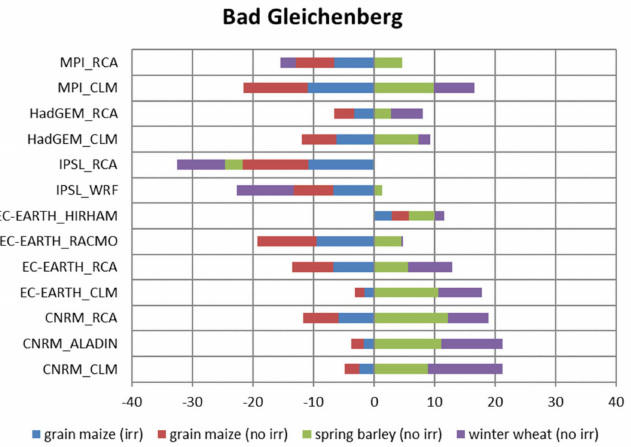
Figure 9. Yield differences (%) among ÖKS15 projections for RCP 8.5 vs. RCP 4.5 for the 2071–2100 period for grain maize (optimal irrigated = irr; rainfed = no irr), spring barley (no irr), and winter wheat (no irr) grown in soil class 2 in Poysdorf.